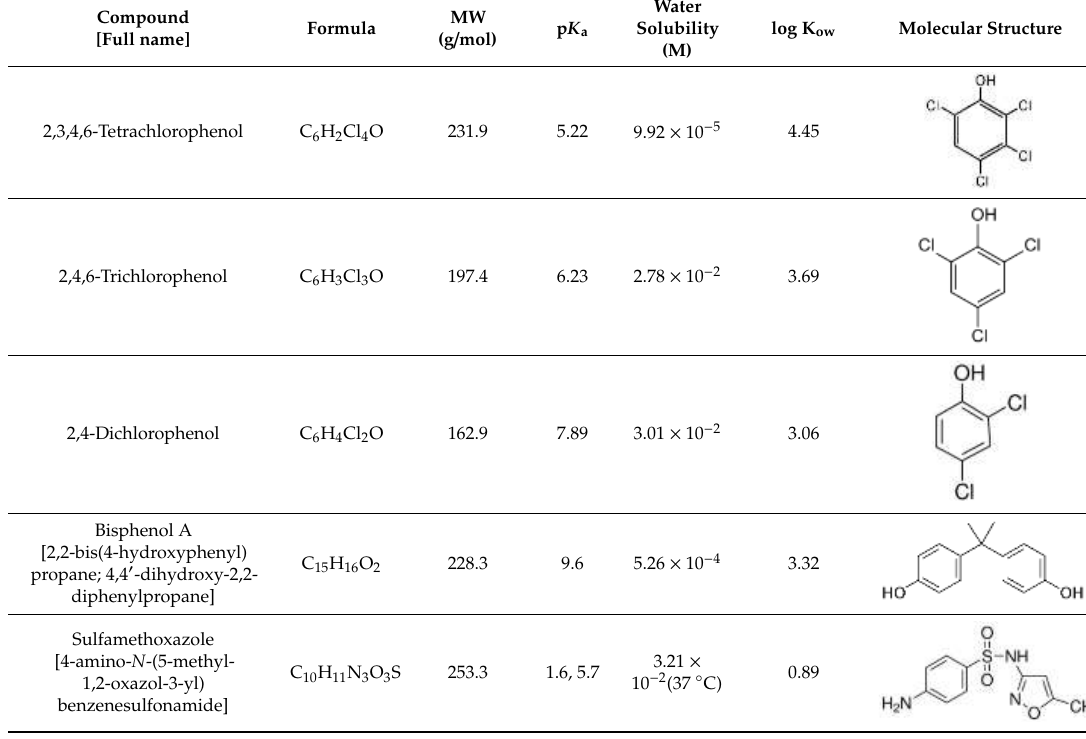
Table 1 summarizes selected physicochemical properties of TeCP, TCP, DCP, BPA, and SMX. Stock and feed solutions were prepared using deionized (DI) water. Table 1. Selected physicochemical properties of 2,3,4,6-Tetrachlorophenol (TeCP), 2,4,6-Trichlorophenol (TCP), 2,4-Dichlorophenol (DCP), bisphenol A (BPA), and sulfamethoxazole (SMX).